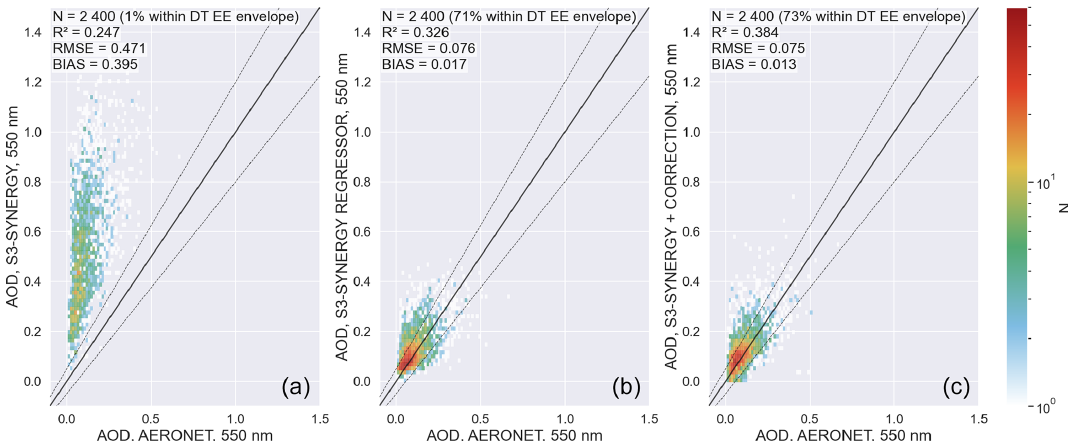
Figure 9. AOD (550nm) for central Europe and the year 2019. Machine learning models are trained using data outside the central European